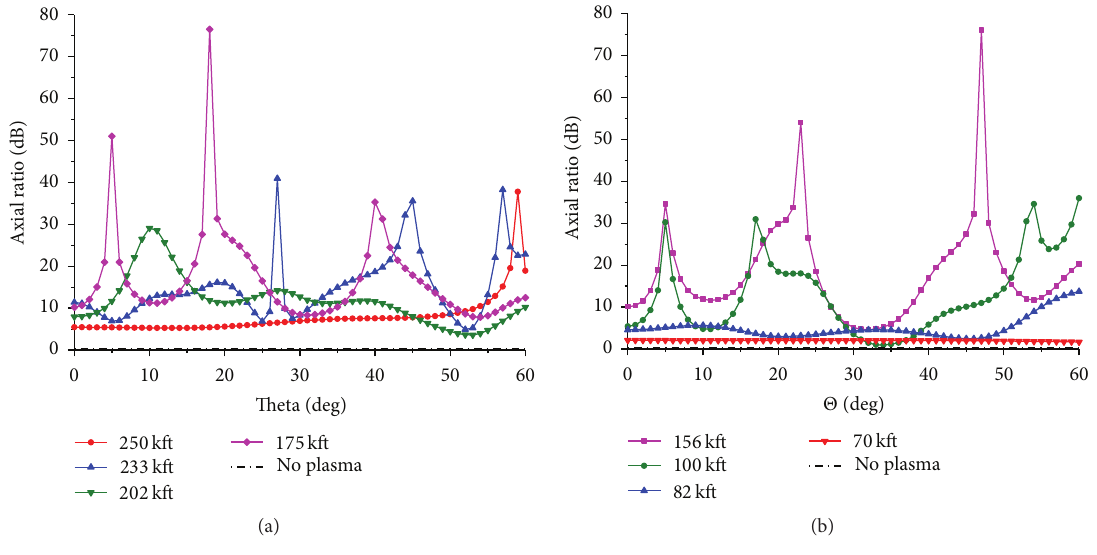
Figure 7: Axial ratio (plane of phi = 90deg) at different altitudes.